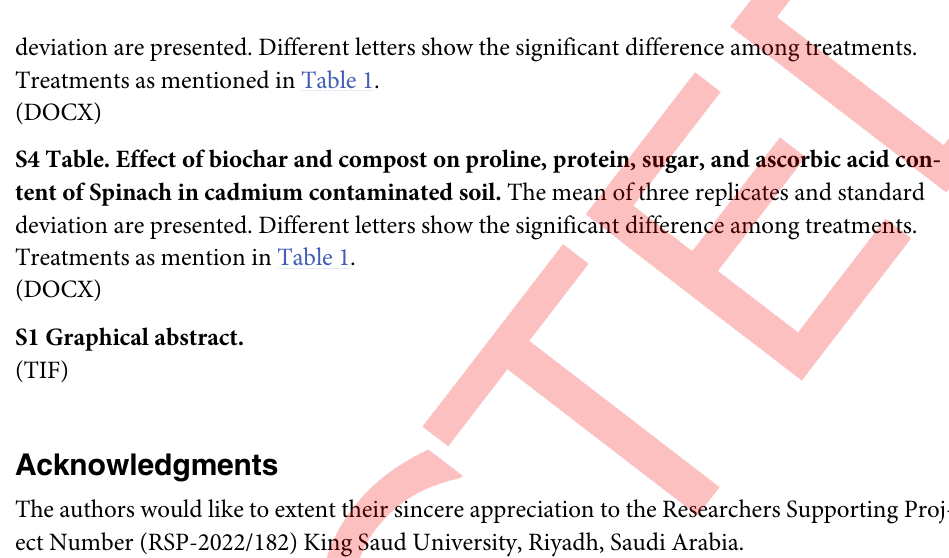
S4 Table. Effect of biochar and compost on proline, protein, sugar, and ascorbic acid con- tent of Spinach in cadmium contaminated soil. The mean of three replicates and standard deviation are presented. Different letters show the significant difference among